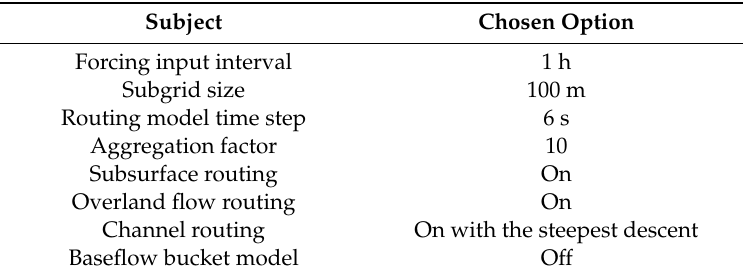
Table 3. Configurations of the WRF-Hydro